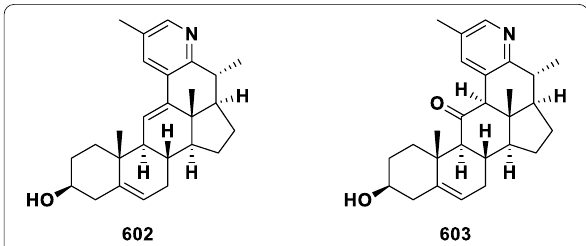
Fig. 13 Structures of others cholestane steroidal alkaloids 602–603